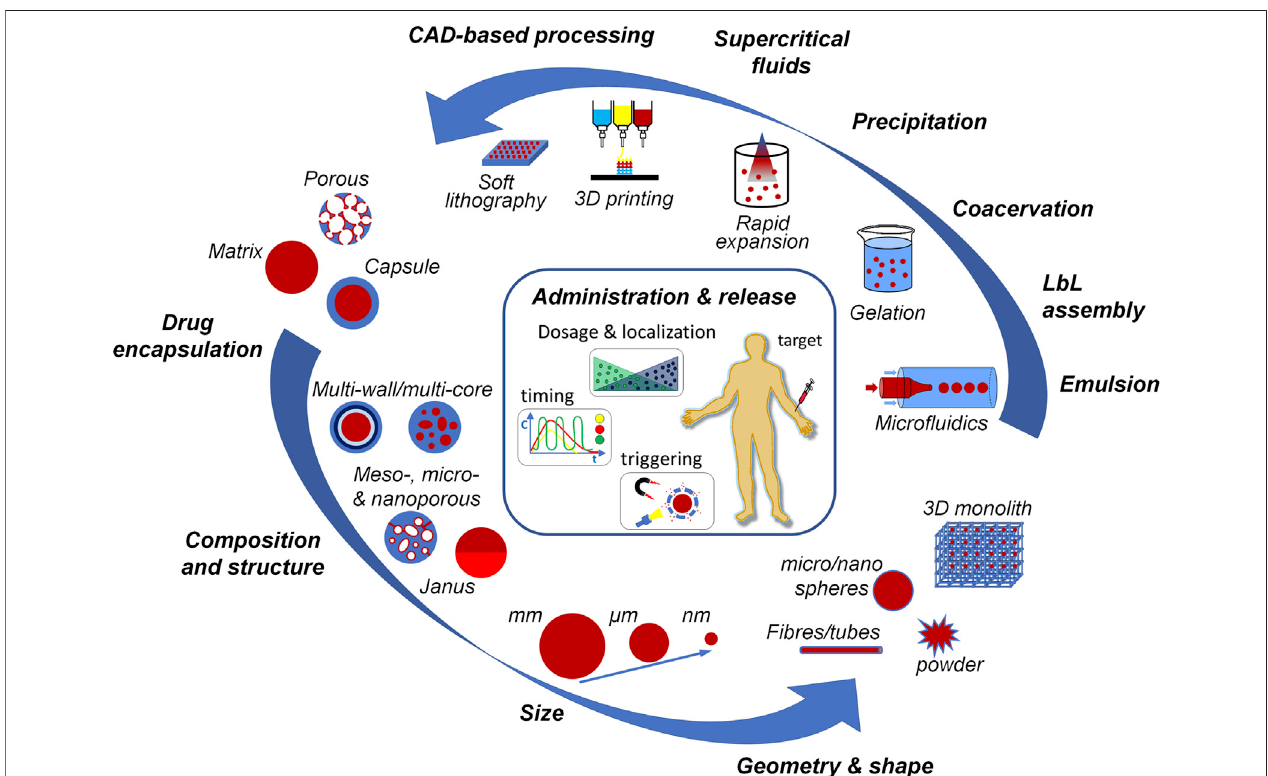
FIGURE1| Picturehighlightingthemainpropertiesofdrugdeliverycarriersandsomeofthemostadvancedprocessingtechniquesforcarriersmanufacturing.The drugcanbeencapsulatedwithinthepolymericmatrix(particles),loadedinthecore(singleandmulti-corecapsules)oradsorbedontotheinnerporesurfaces.Thecontrol of drug release is achievable by tuning carriers ’ composition, structure, size and shape and by the optimization of the fabrication technique and processing